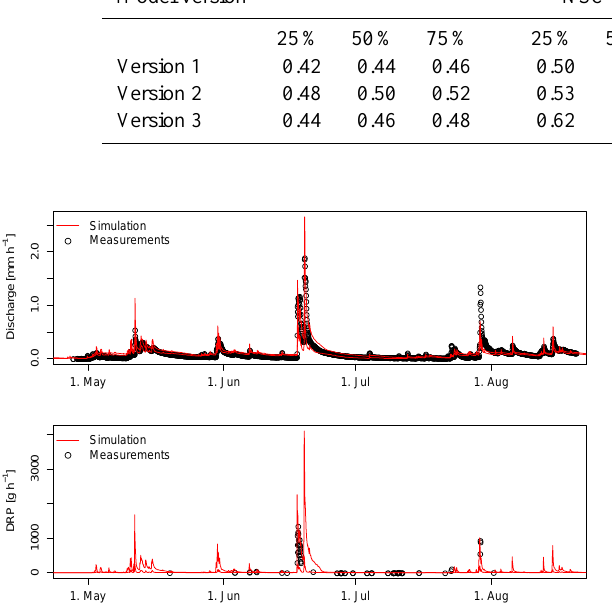
Fig. 5. Simulations (lines, 10% and 90% quantiles) using RRP Ver- sion 3 versus measured (points) discharge and DRP loss from the Stägbach catchment in